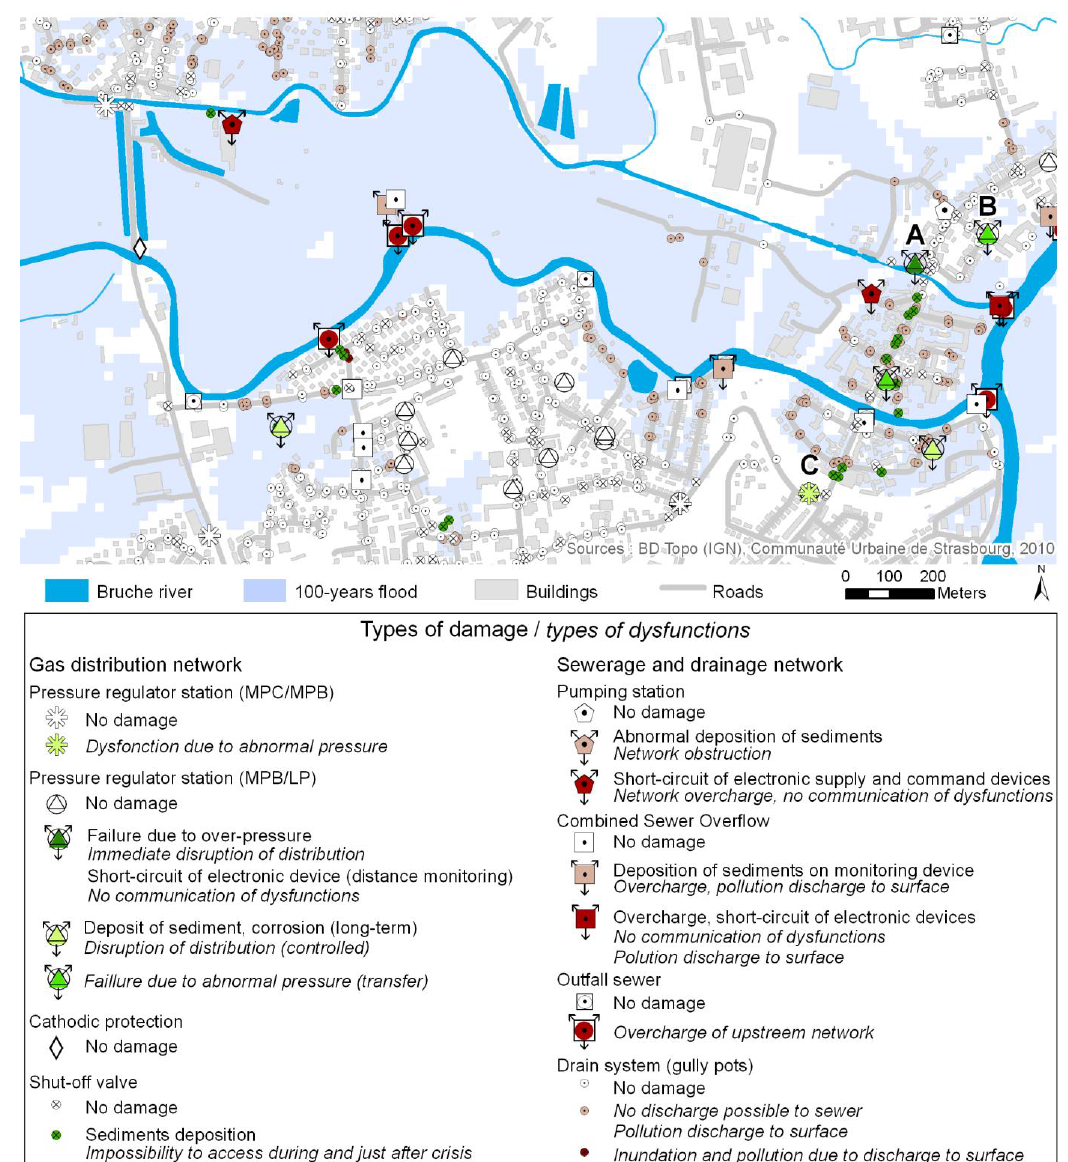
Figure 6. Map of damage-dysfunctions caused by a 100-year return-period flood for the components 2 of gas distribution and sewerage/drainage networks. 3